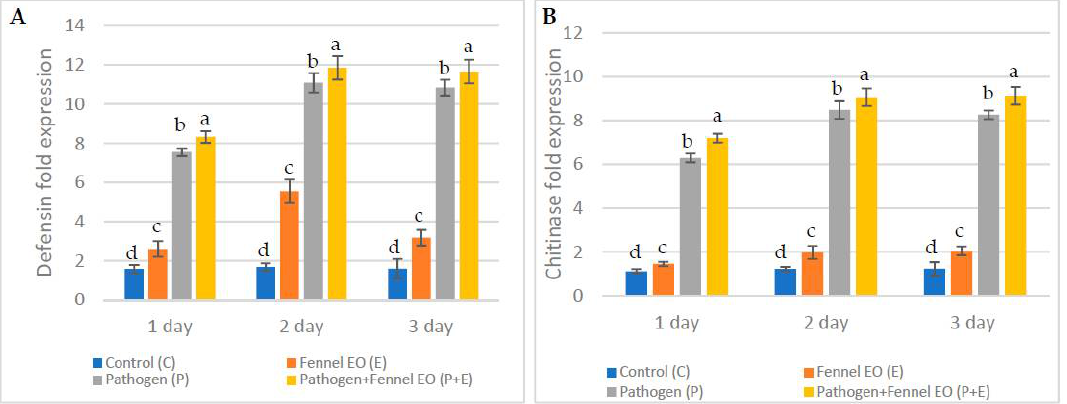
Figure 5. Fold expression in the accumulation of the defense-related genes ( A ) defensin and ( B ) chitinase in Vicia faba L. samples, at different treatments relative to the control, and at different periods. Values are the means ( ± SD) of three repeated experiments. Different alphabetic superscripts in the same column are significantly different ( p < 0.05) based on Tukey’s multiple comparison test.